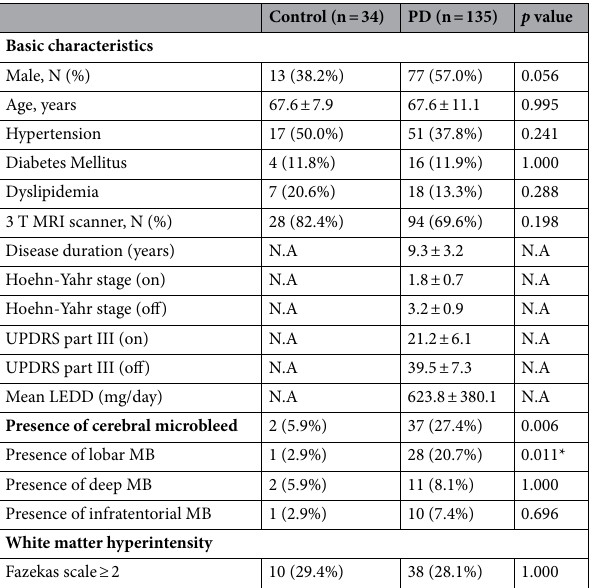
Table 1. Comparison of microbleed in patients with PD and healthy controls. Values are given as mean ± standard deviation or n (%). “On” state was defined as 60–90 min after the administration of dopaminergic medications and “Off” state was defied as discontinuation of any form of dopaminergic medications for at least 12 h (usually an overnight withdrawal). N number, PD Parkinson’s disease, MB microbleed, UPDRS Unified Parkinson’s Disease Rating Scale, LEDD levodopa equivalent dose, N.A . not